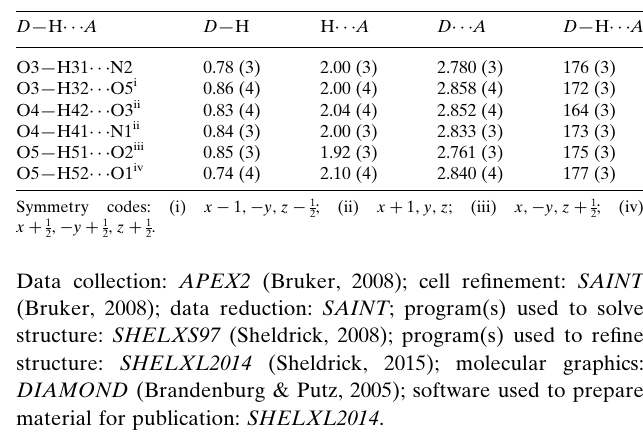
Hydrogen-bond geometry (A˚ , (cid:4)